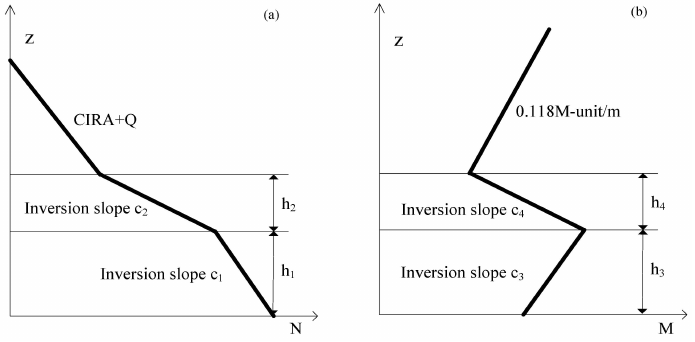
Figure 2. Four-parameter geometric scheme of the atmospheric